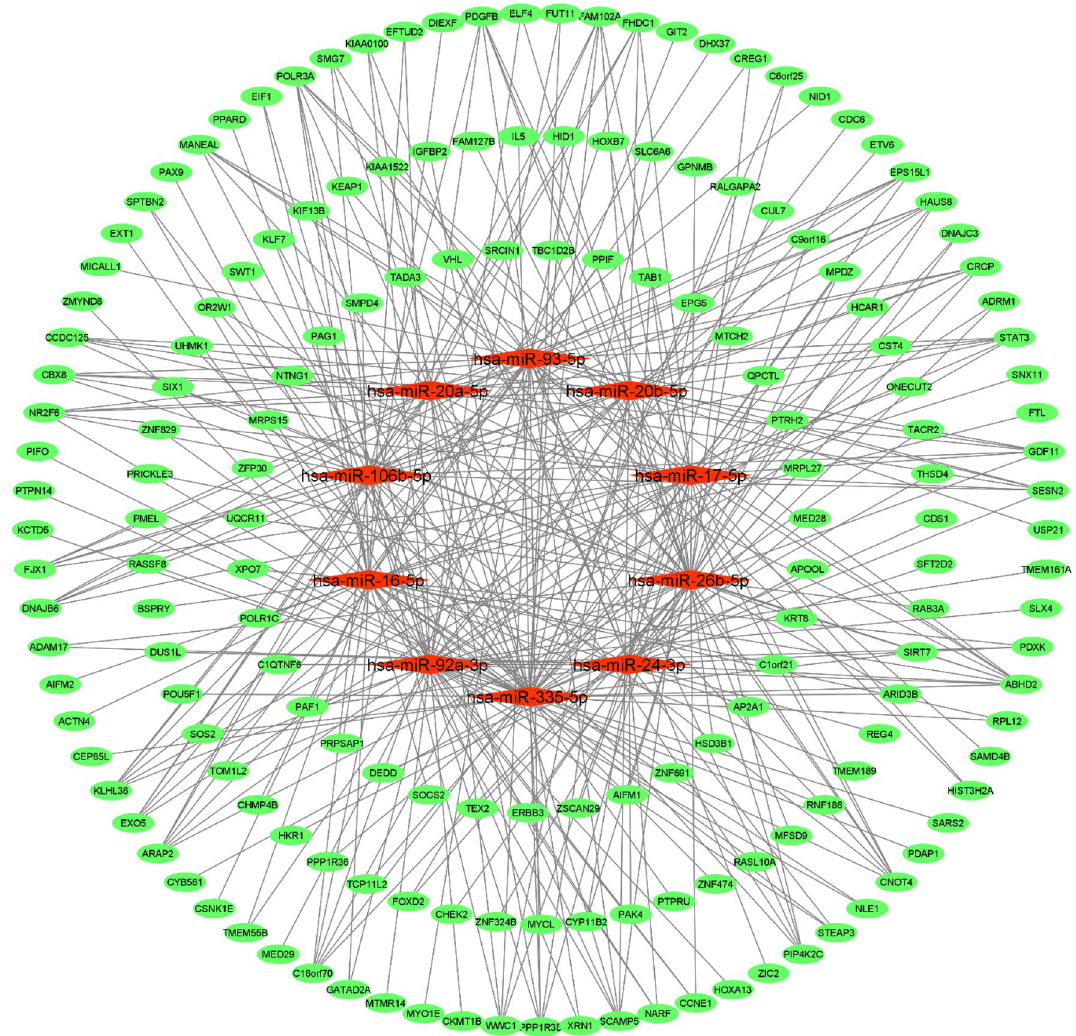
Figure 2. Bipartite mRNA-miRNA subnetwork for PBC-RNIT. Cytoscape v.3.8.2 was used to visualize the